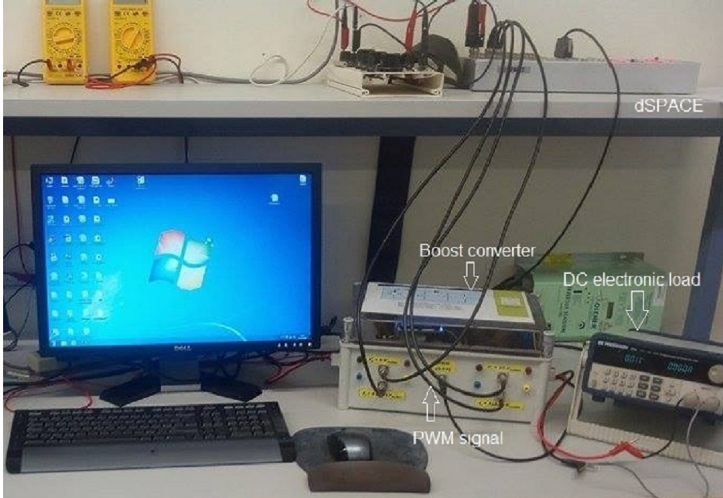
Figure 11. The real system.